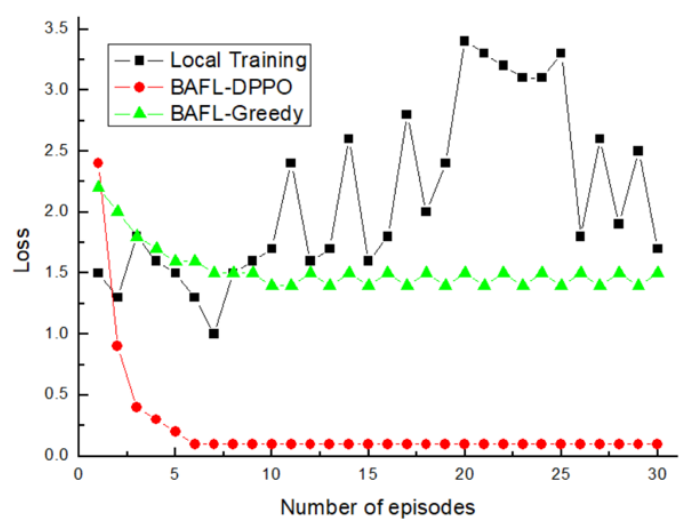
Figure 8. Comparison of losses (30% of malicious device nodes).